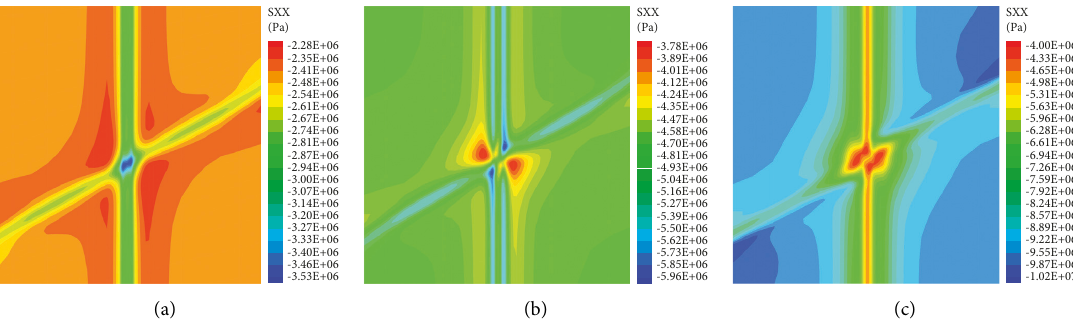
Figure 10: Disturbance influence of buried depth on surrounding rock horizontal stress of staggered roadways. (a) 100m roadway buried depth, (b) 200 m roadway buried depth, and (c) 400m roadway buried depth.